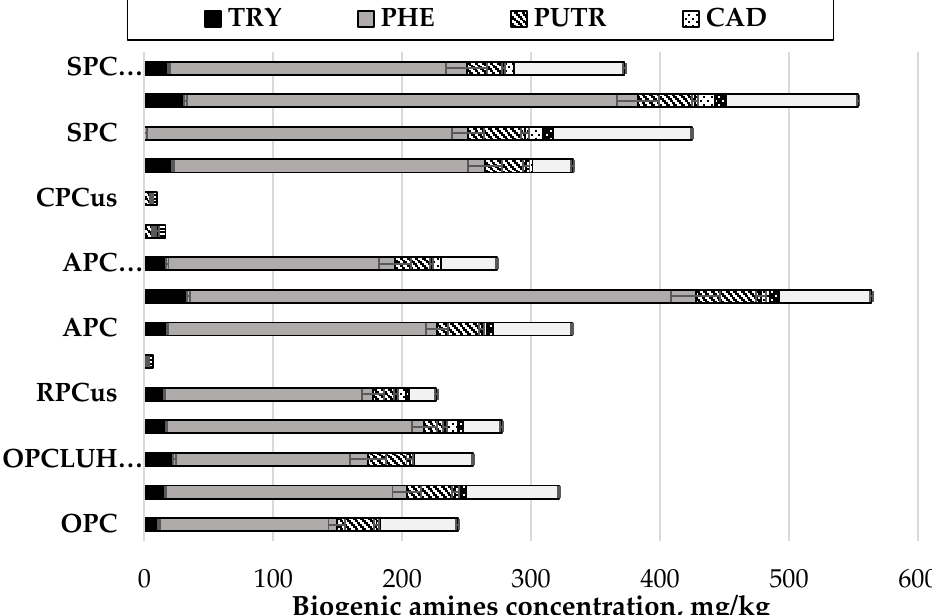
Figure 2. Biogenic amines concentration (mg / kg) in ultrasound treated and fermented with LUHS210 strain byproducts. Data are represented as means ( n = 3) ± SD. RPC — rice press cake; SPC — soy press